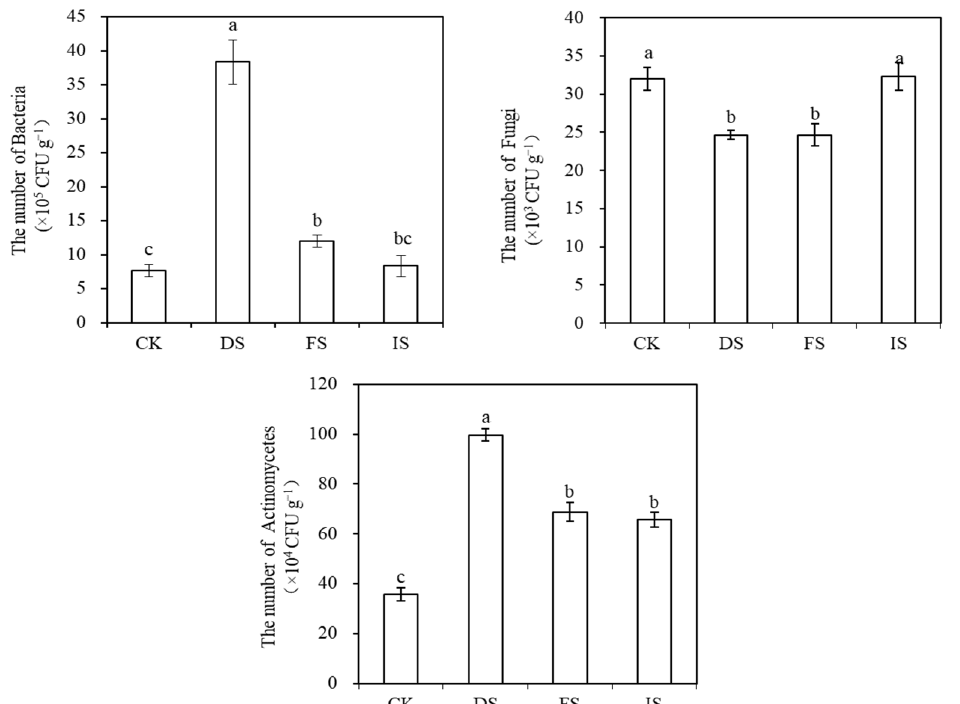
Figure 5. Effects of different forms of Tateges erecta biofumigation on the abundance of bacteria, fungi and actinomyces. CK: replanted soil, DS: air-dried T . erecta sample, FS: fresh T . erecta sample, IS: infusion solution of fresh T . erecta . Data are the means of three replicates, and the different letters over the columns indicate significant differences at p < 0.05. Table 4. Fungal diversity in soils biofumigated with different forms of Tateges erecta .